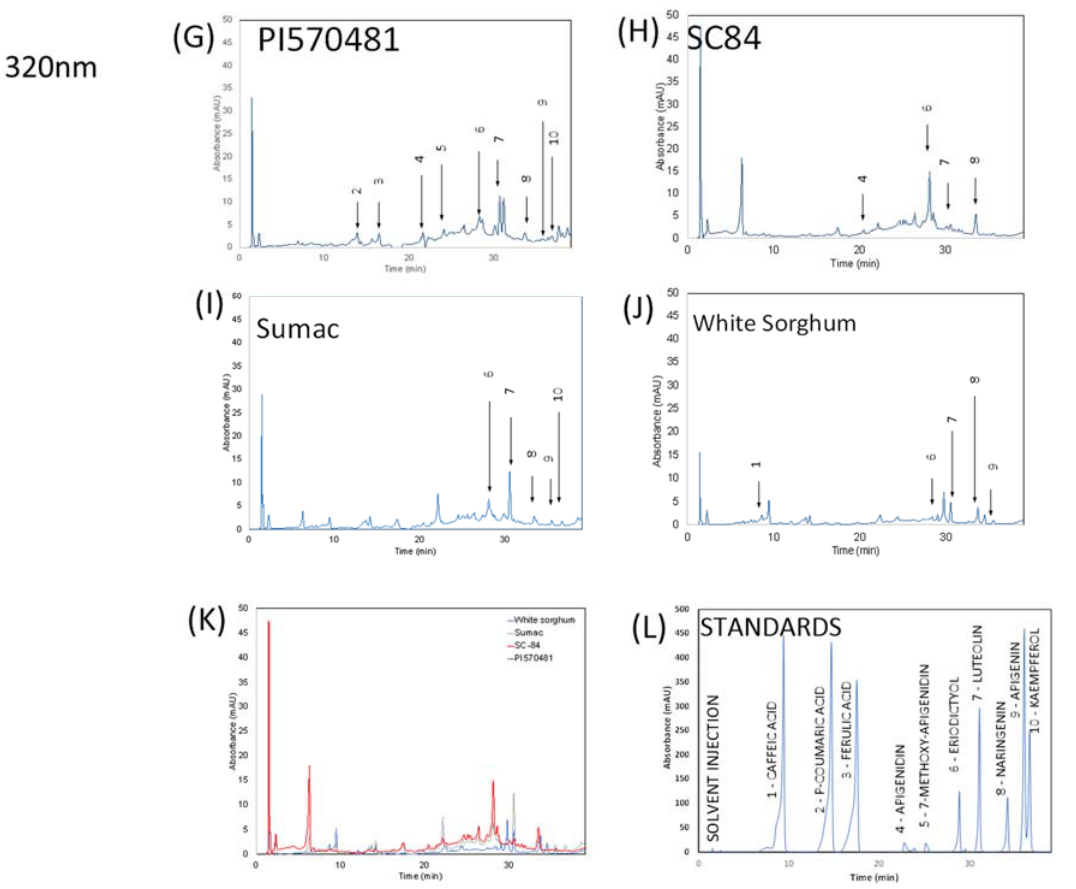
Figure 1. HPLC analysis of sorghum extracts. The chromatograms of sorghum varieties (5 mg/mL of dried extract) at 280 nm ( A – D ), sorghum genotype chromatograms overlaid at 280 nm ( E ) and the mixture of standards (0.09 mg/mL) at 280 nm ( F ), (5 mg/mL of dried extract) at 320 nm ( G – J ), sorghum genotype chromatograms overlaid at 320 nm ( K ), and the mixture of standards (0.09 mg/mL) at 320 nm ( L ).